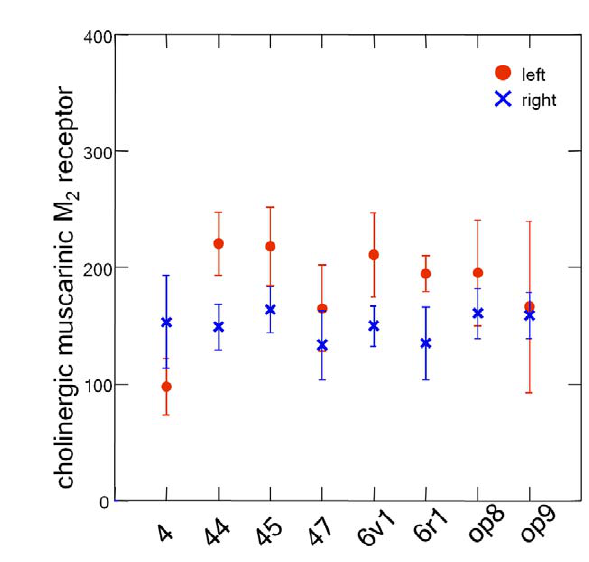
Figure 11. Interhemispheric differences in the concentration of receptor binding sites of the muscarinic M 2 receptor per area. This receptor type differed significantly between left and right hemispheres with higher values on the left than on the right ( p , 0.05). Means in fmol/mg protein and standard errors of arithmetic